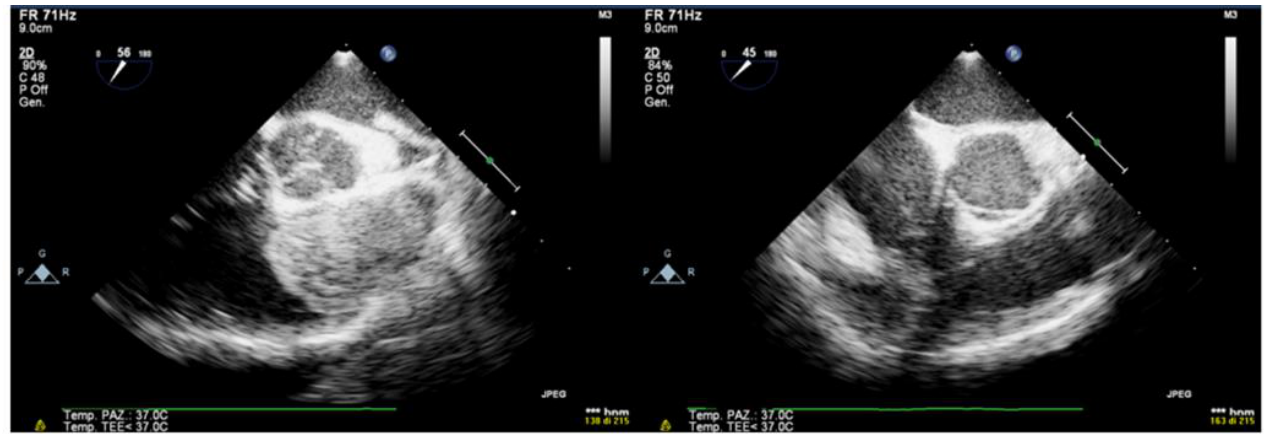
Figure 3. Color Doppler transesophageal echocardiography. Transesophageal echocardiogram through the mid-esophageal 30° and 60° view, be- fore and after surgery resection of myxoma, shows the complete resolution of RVOT ob- struction.